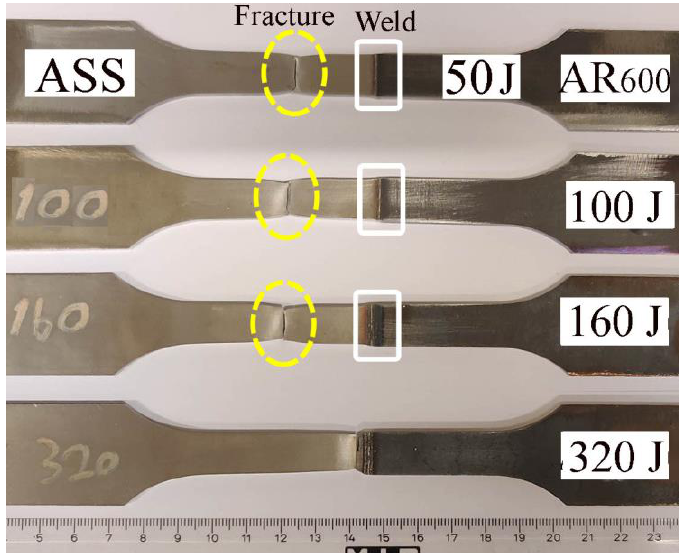
Figure 13. Macrograph images of the tensile samples of the dissimilar joints after testing showing the fraction positions in the post-weld joints that were heat-treated at 250 °C.